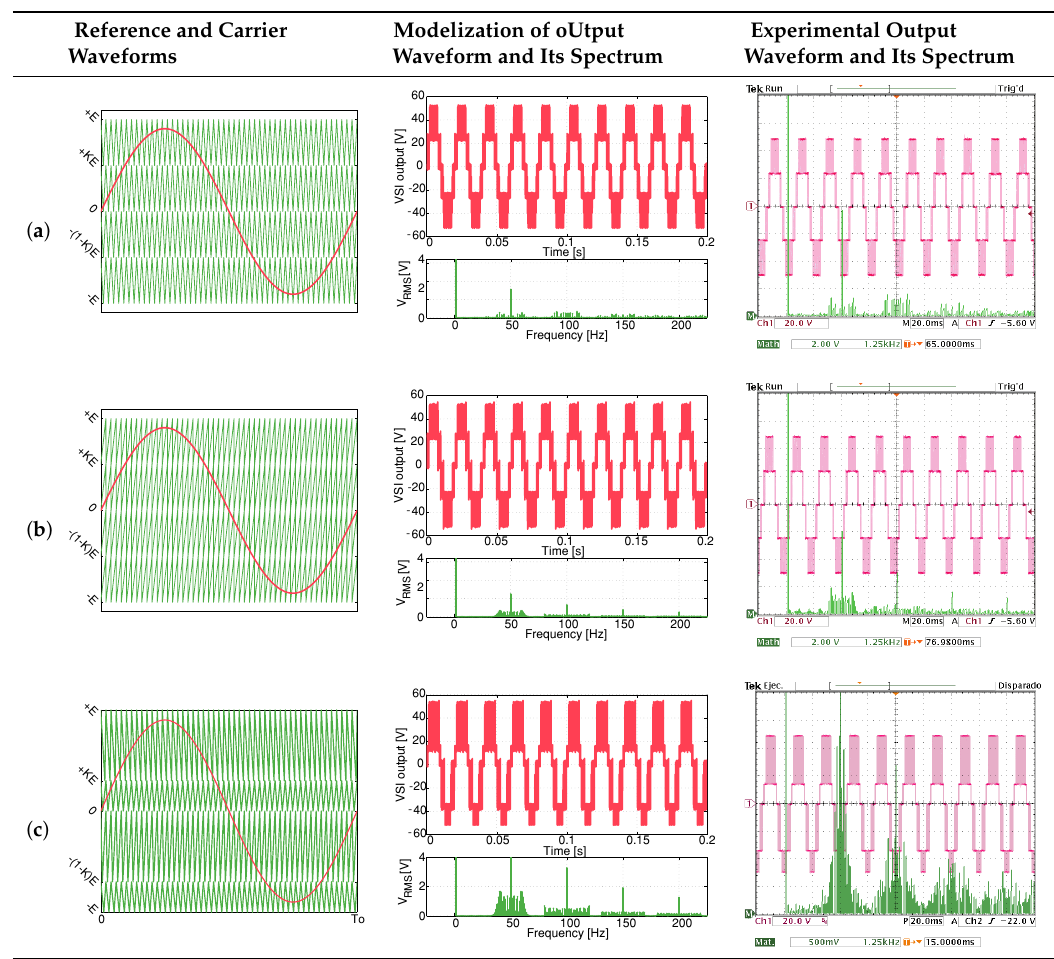
Table 6. Pseudo-natural against natural sampling with PD-SPWM, E = 50 V, M f = 50, and M a = 0.9 for ( a ) K = 0.5 and r 1 = r 2 = r 3 = r 4 = 0.5; ( b ) K = 0.5 and r 1 = r 2 = r 3 = r 4 = 1; abd ( c